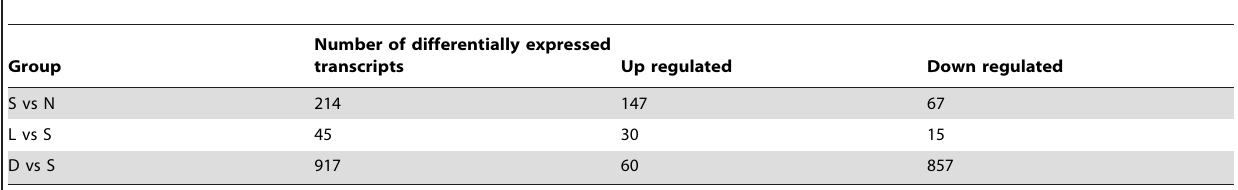
Table 4. Number of differentially expressed transcripts in each of the experimental